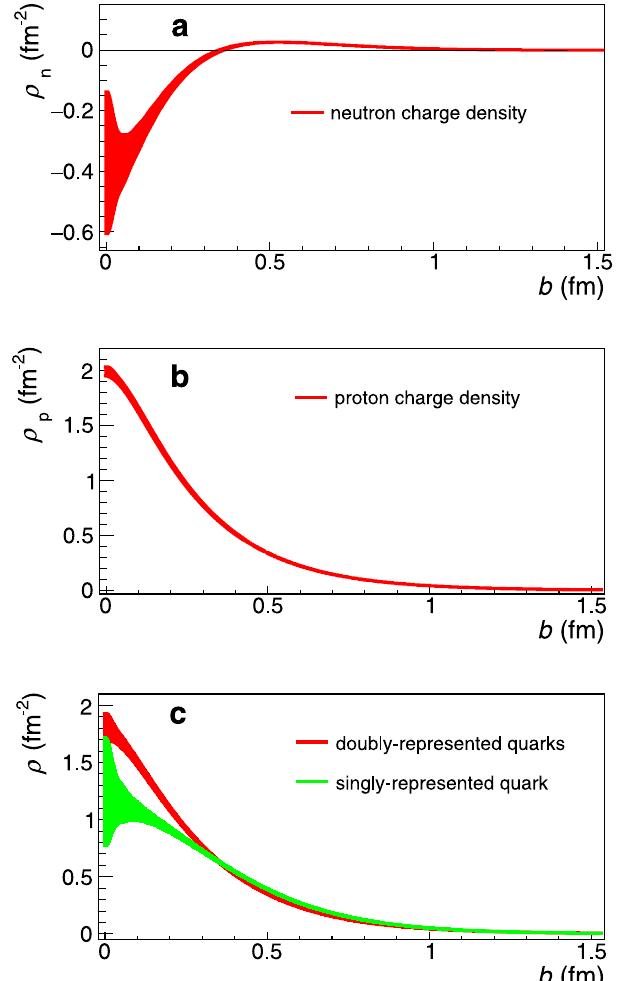
Fig. 5 The nucleon charge densities. a The neutron charge density ρ n . b The proton charge density ρ p . c Flavor decomposition of the nucleon charge densities: the doubly-represented (red) and singly-represented (green) charge densities in the nucleon. Each is normalized to